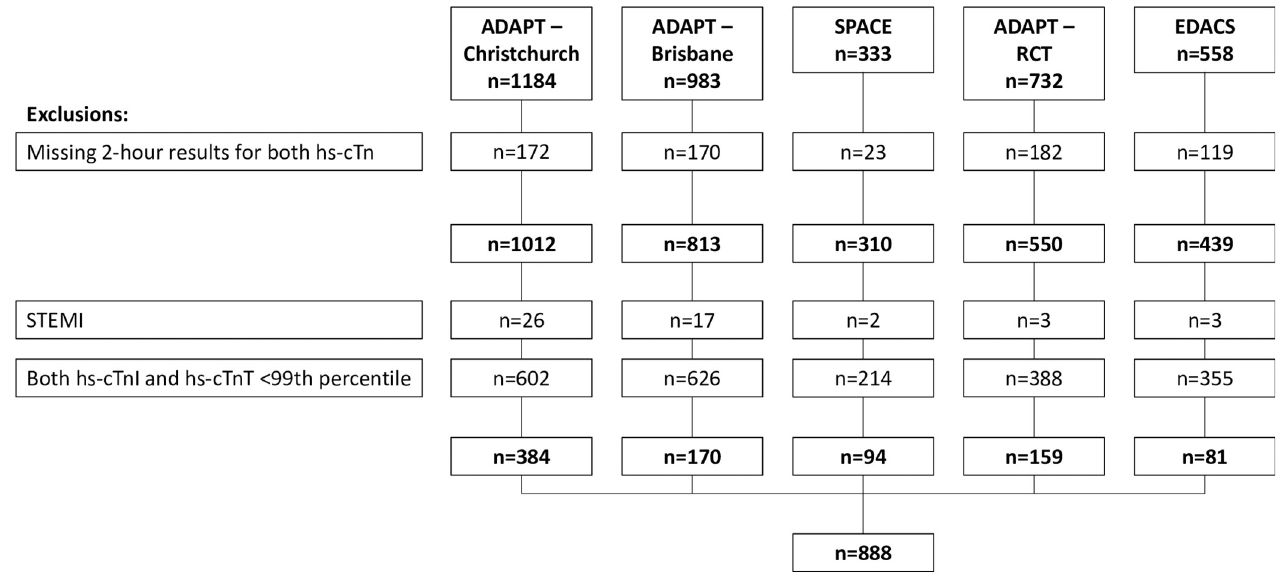
Fig 1. Study flowchart. STEMI: ST-elevation myocardial infarction.